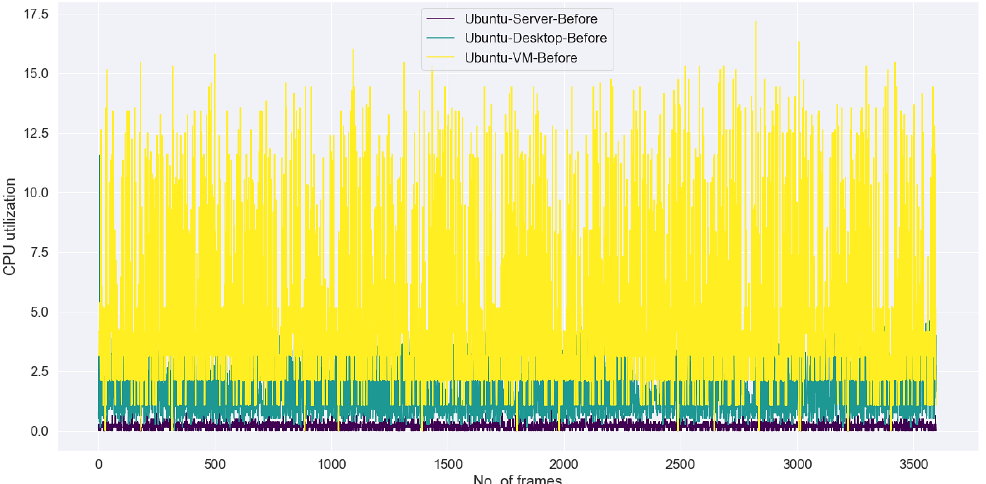
Figure 40. Ubuntu Server, Desktop, and VM CPU utilization before OpenStack installation.